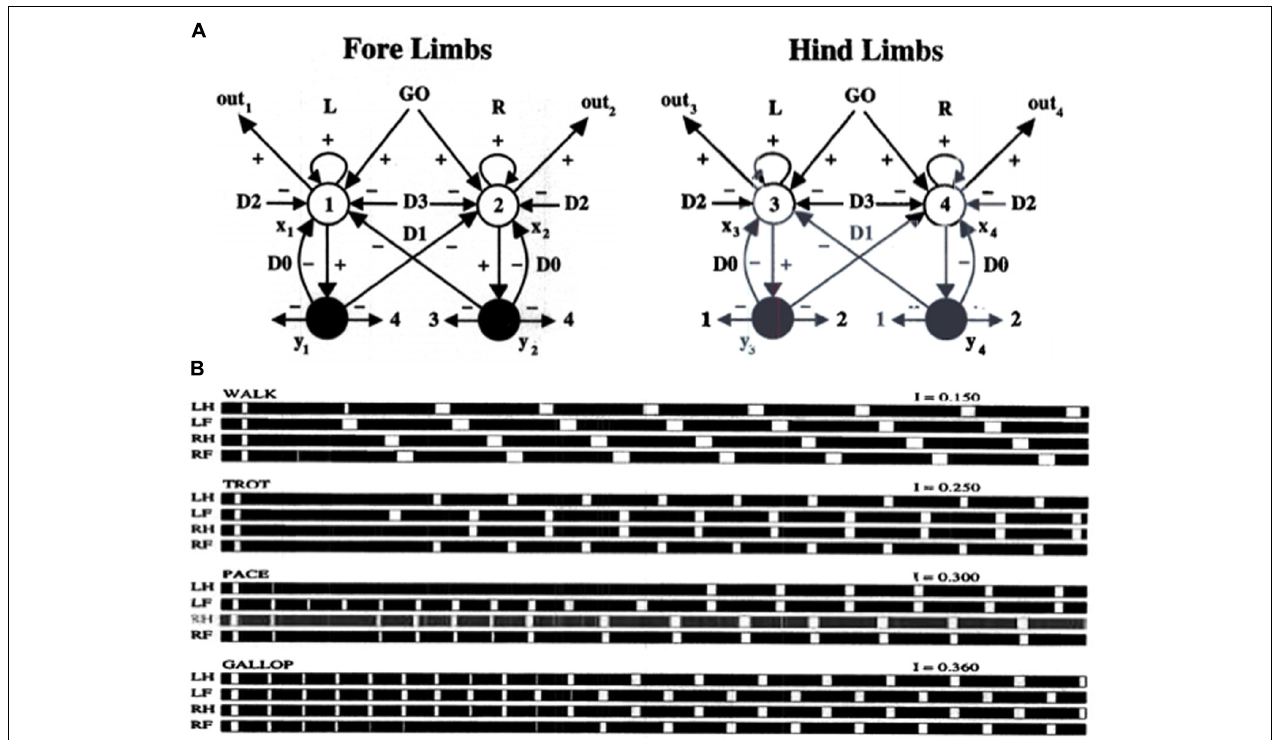
FIGURE 12 | A central pattern generator, or CPG, that is capable of generating well-known series of movement gaits using a recurrent on-center ( + signs) off-surround ( – signs) network whose cells obey the membrane equations of neurophysiology (shunting interactions) when it is activated by a GO signal of variable size: (A) The network is defined by a four-channel oscillator. Inhibitory connections between the forelimbs and hindlimbs are represented by arrows originating at the source of the inhibition and numbered by the label of the cell that is the destination. A like-labeled arrow represents the destination of this inhibition. The network has self-inhibition labeled by the parameter D0, inhibition between forelimbs and between hindlimbs labeled by D1, inhibition between matched forelimbs and hindlimbs labeled by D2, and connections between crossed forelimbs and hindlimbs labeled by D3. (B) Computer simulation of how an increasing GO signal, along with GO-modulated modulation of the inhibitory coefficients, yields an ordered series of gaits (walk, trot, pace, and gallop) as an emergent property of network interactions. [Reprinted with permission from Pribe et al.,